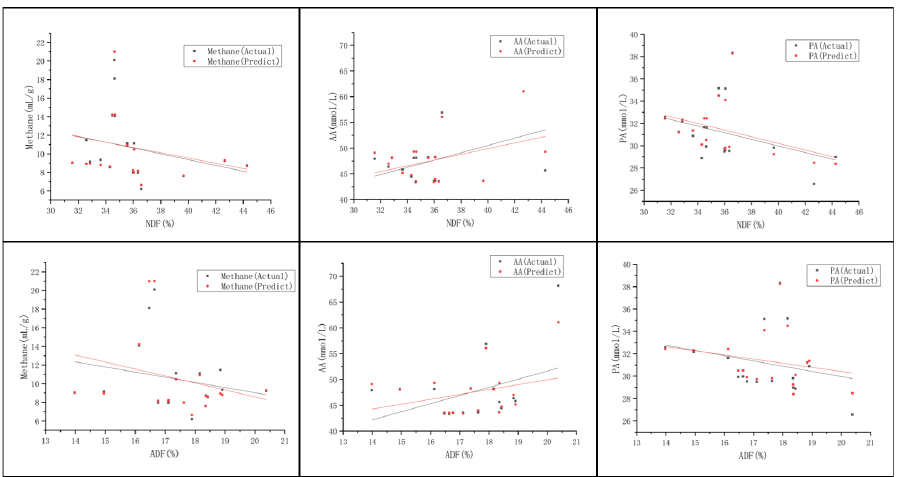
Figure 4. Scatter plots of actual values of methane, AA, and PA and values predicted by the stacking model at different NDF and ADF